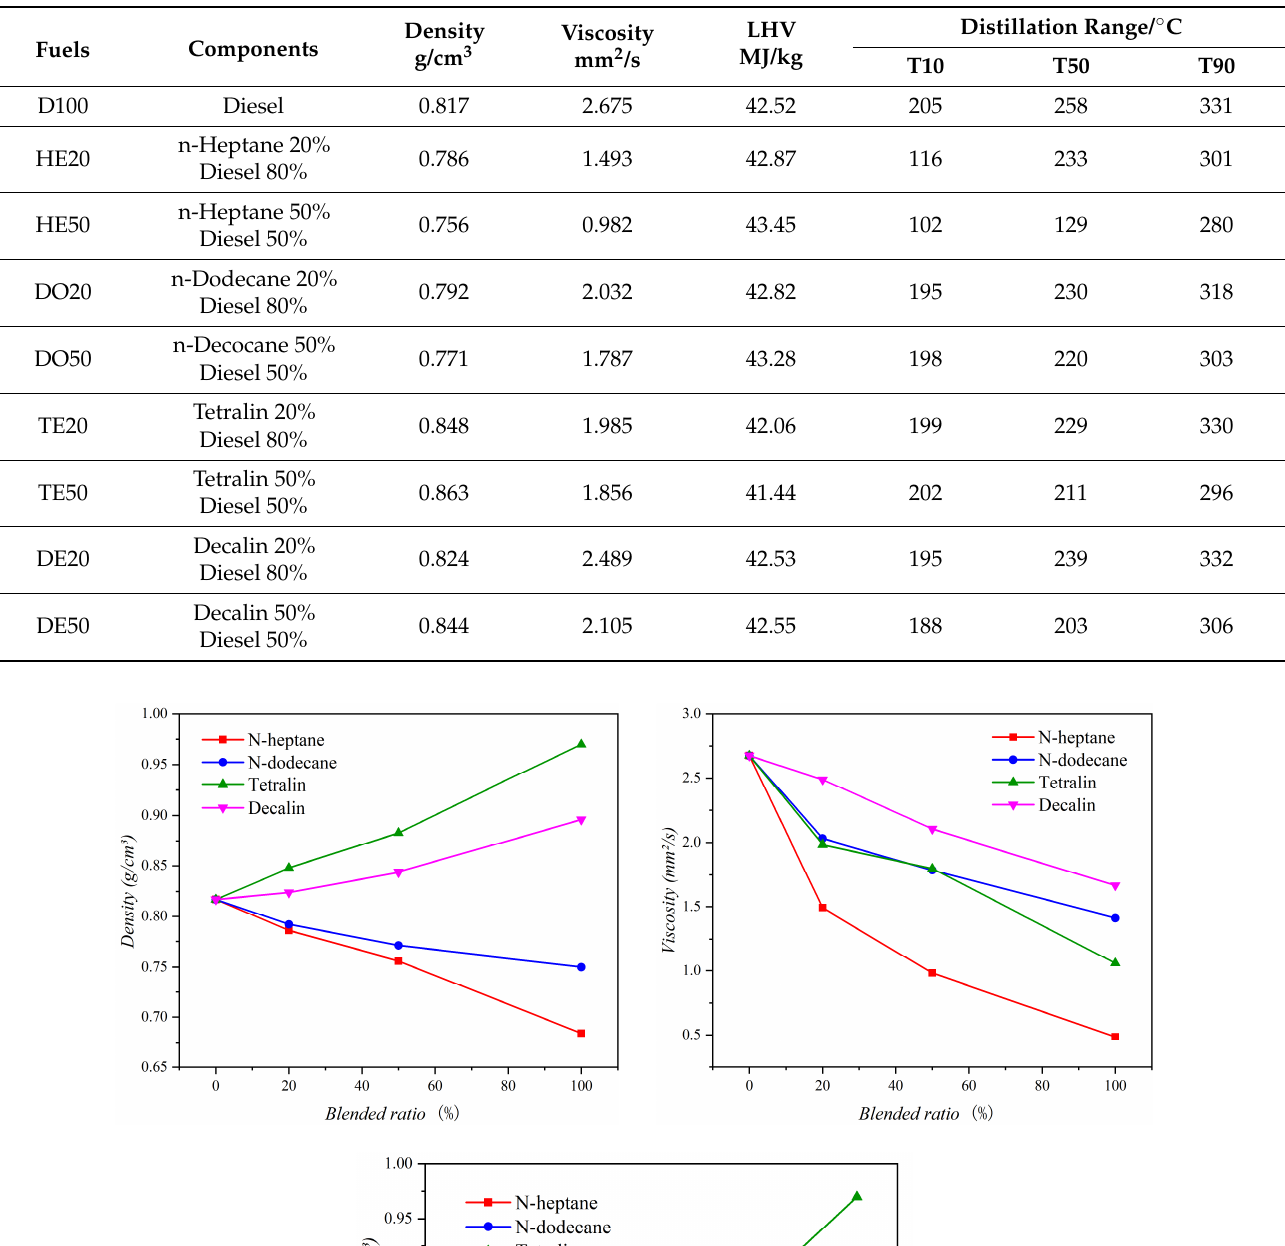
Table 2. Main properties of test fuels.